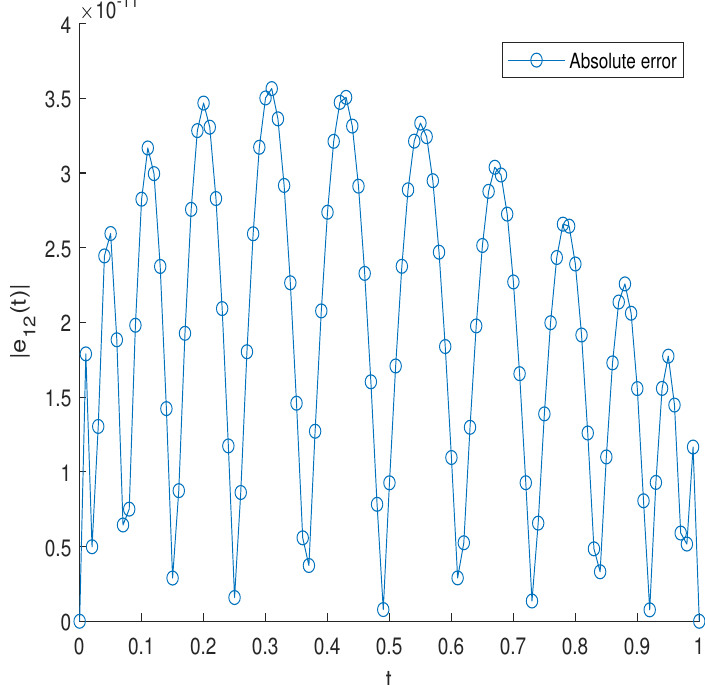
Figure 6. The absolute error for Example 3 and N =